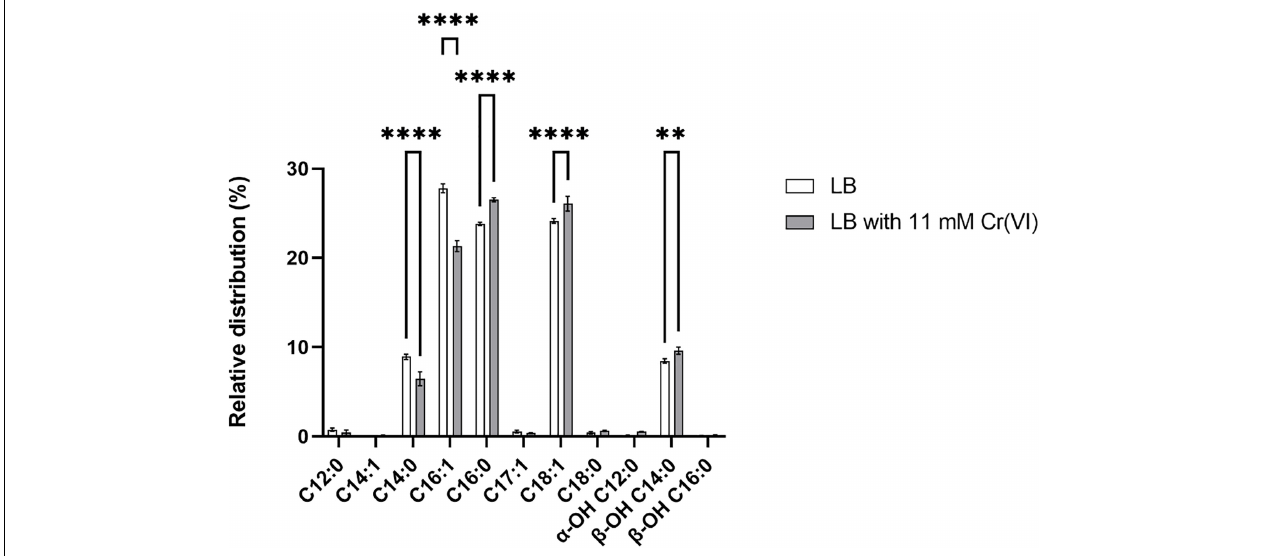
FIGURE 8 | Relative distribution of fatty acid methyl esters (FAMEs) of Klebsiella sp. strain AqSCr cells adapted to 11 mM Cr(VI) or grown in LB (pH 8) (controls). Each column represents the mean ± SEM of three independent replicates. Significant difference for specific FAMEs compounds of Cr(VI)-treated cells vs. control (LB), using a two-way ANOVA followed by a Sidak’s multiple comparison test. **** p < 0.0001, ** p < 0.0016, n = 3. Bars represent mean ±